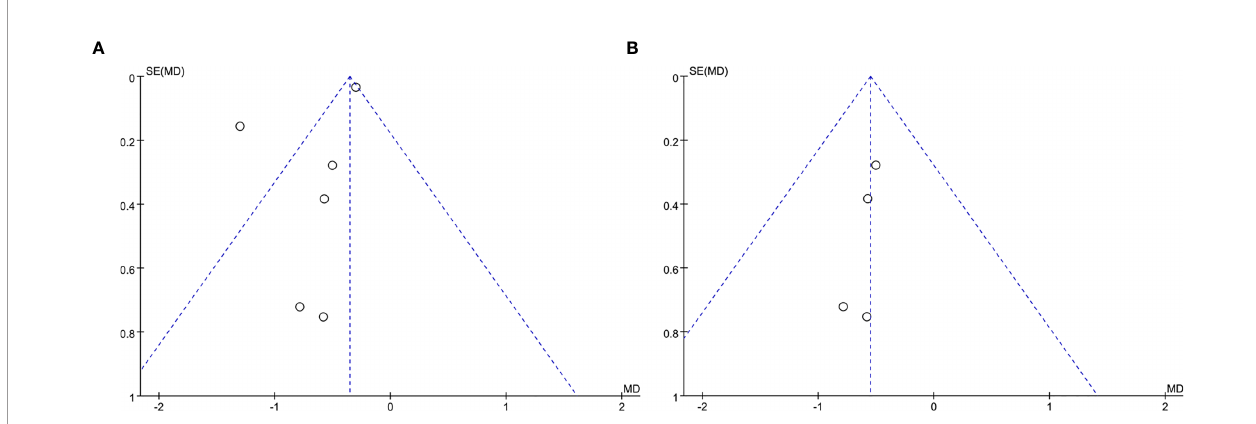
FIGURE 8 | (A) Funnel plot of publication bias among studies analyzing AAA growth rate. (B) Funnel plot of publication bias after deleting questionable